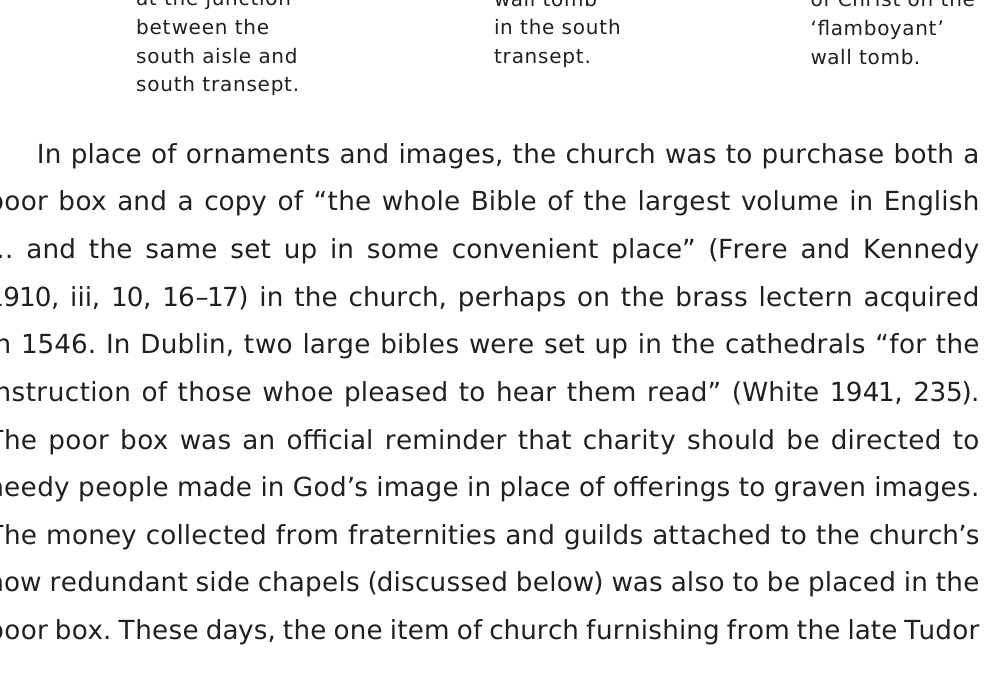
Figure 7 The ‘flamboyant’ wall tomb in the south transept.